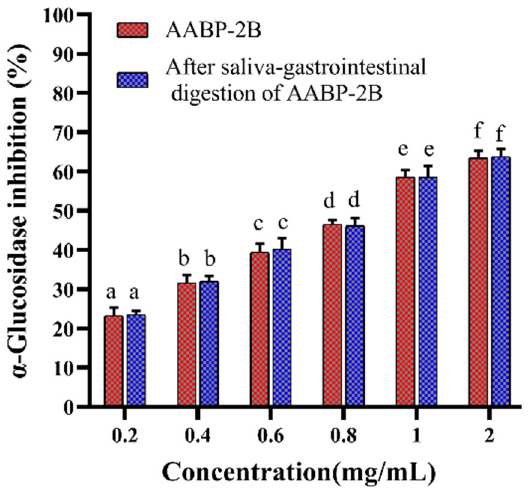
Figure 4. α -Glucosidase-inhibitory activity of AABP-2B during saliva–gastrointestinal digestion. Statistically signi fi cant di ff erences were observed between di ff erent le tt ers ( p < 0.05).